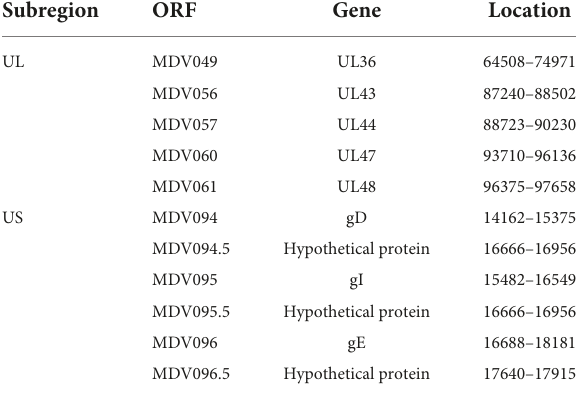
TABLE 1 The hot spots of recombination in the unique long (UL) and unique short (US) subregions of Marek’s disease virus (MDV)